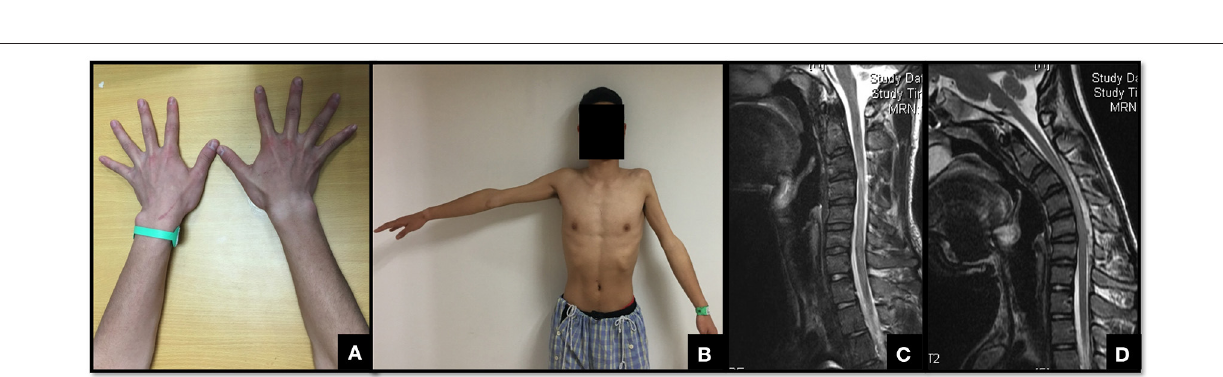
Frontiers in Neurology |